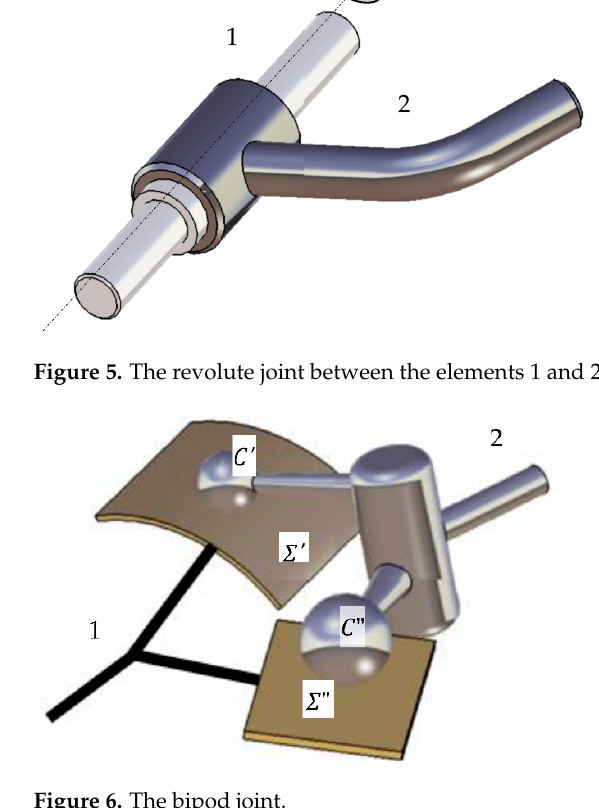
Figure 6. The bipod joint.